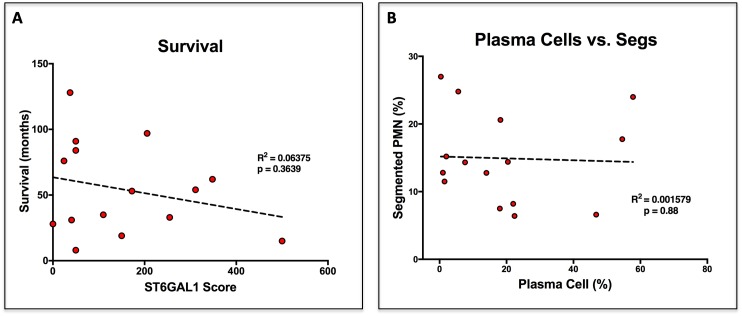
Survival and Plasma Cell Abundance are not altered by ST6GAL1 Expression.(A) Correlation between ST6GAL1 score and patient survival in months. (B) Correlation between disease burden, enumerated as frequency of plasma cells in the bone marrow, and frequency of neutrophils.